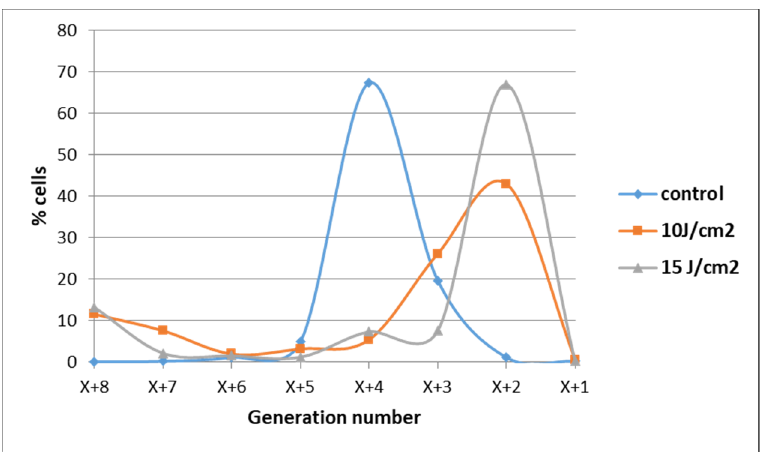
Figure 6. Demonstrative data on the proliferation of HT29 tumor cells subjected to PDT (fluences: 10 J/cm 2 and 15 J/cm 2 ; fluence rate: 50 mW/cm 2 ) vs. non-treated control cells at 72 h post-PDT. Results are presented as a percentage of cells in various consecutive daughter generations in comparison with the parent population distanced by X previous generations. Data were obtained by flow cytometry with CFDA-SE and were processed using the ModFit LT software.